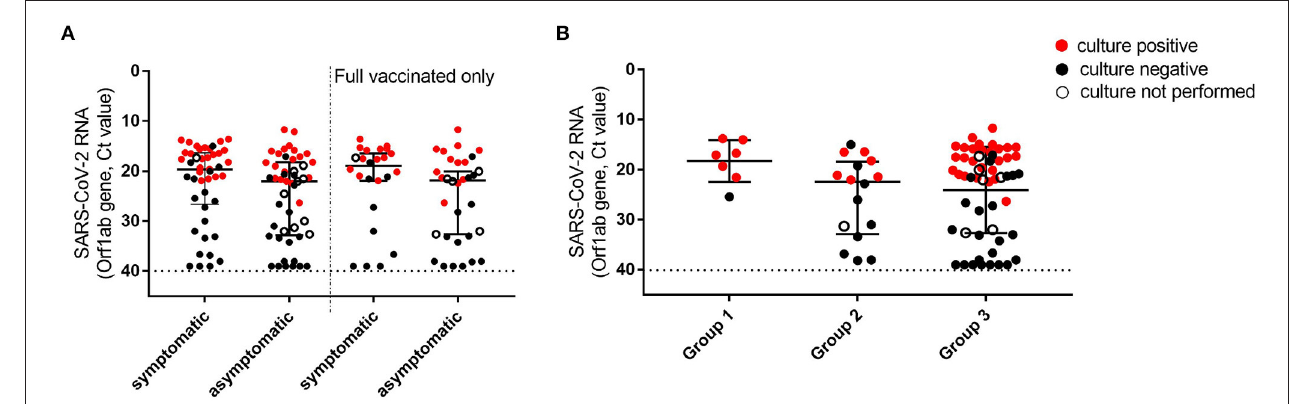
FIGURE 1 | Viral loads and viral culture outcomes in NPSs collected in individuals tested positive after first dose vaccination. (A) Viral loads were detected in all symptomatic and asymptomatic individuals at the time of diagnosis (left, n = 45 and 49, respectively), and in a subgroup (Group 3) including only individuals who tested positive after 10 days from second dose vaccination (right, n = 24 and 32, respectively). (B) Viral loads detected in NPSs were collected at different time points from the first dose vaccination. Group 1 (time lapse 1–15 days), n = 7; Group 2 (16–30 days), n = 16; Group 3 ( > 30 days), n = 56. Viral RNA levels are expressed as Ct of Orf1ab gene amplification, the horizontal dashed line represents the limit of detection of RT-PCR (Ct: 40). Median Ct values and IQR are shown. Statistical analysis was performed in (A) by Mann–Whitney test, p = 0.053 (left) and p = 0.098 (right); in (B) by Kruskal-Wallis test, p = 0.135. Samples yielding positive or negative viral culture are indicated in red and black, respectively; empty dots indicate samples for which viral culture was not performed.